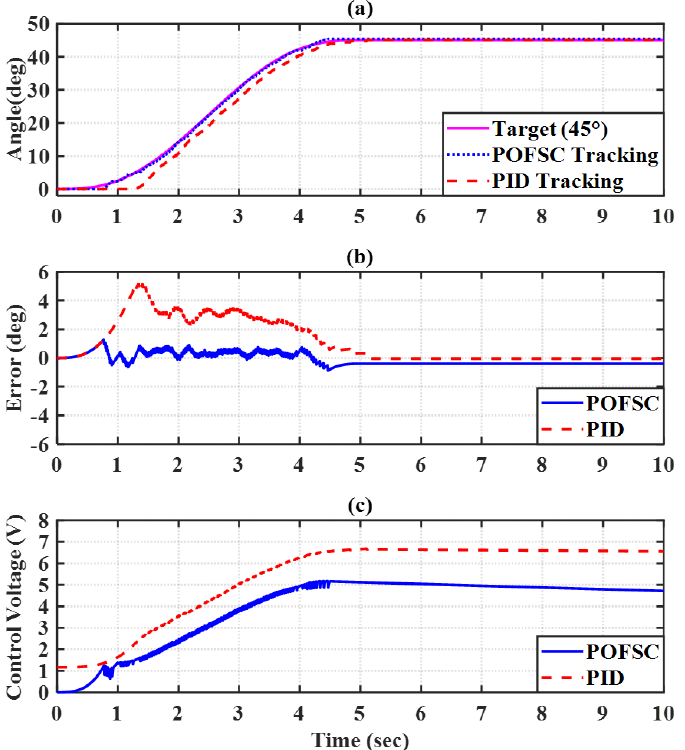
Figure 16. Comparison of fifth-order path-tracking between the POFSC and PID for the shoulder joint flexion angle of 45°. ( a ) System response, ( b ) tracking error, and ( c ) control voltage.